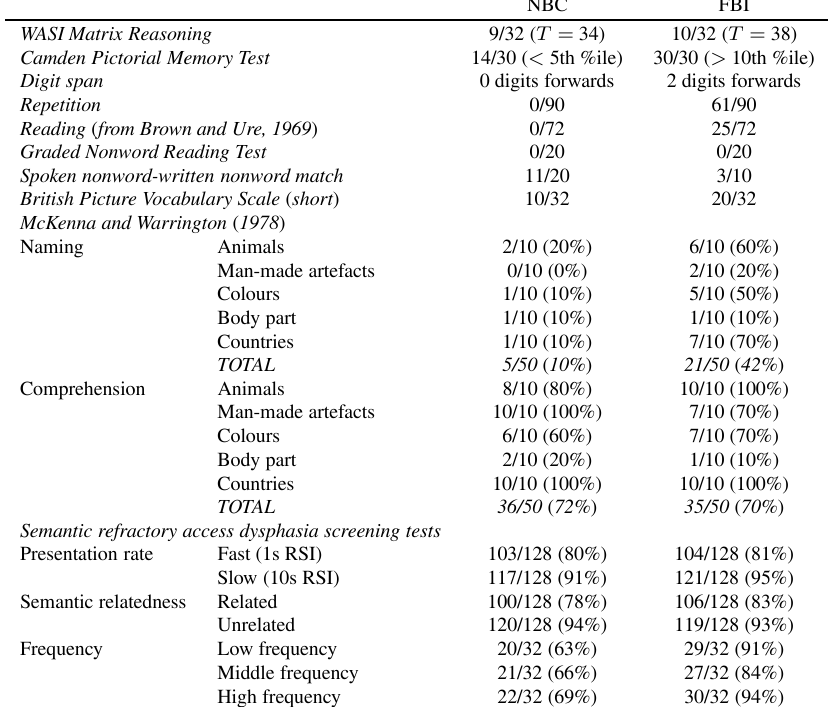
Table 1 The number and percentage correct responses on the background screening